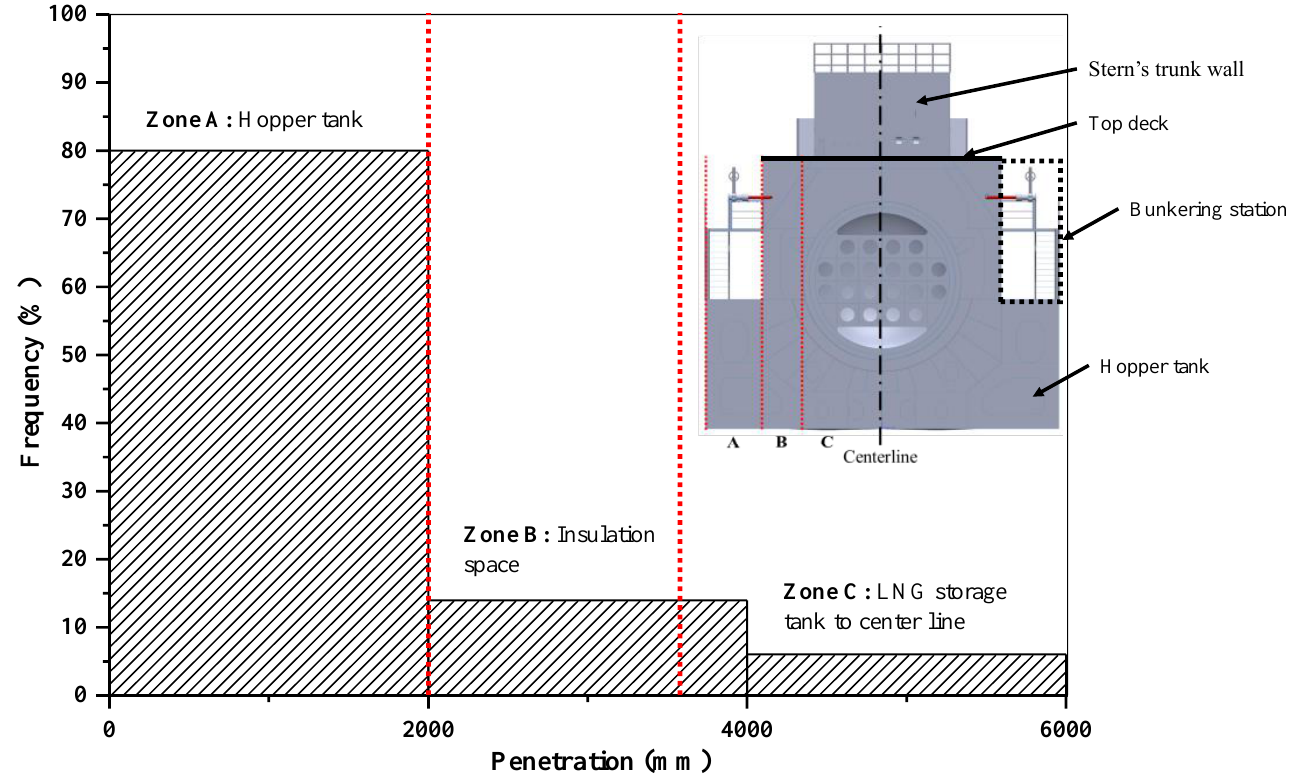
Figure 2. Frequency of penetration distance. The penetration region was categorized into zones A, B, and C, which represent slight, middle, and severe penetrations, respectively. Zone B, which has 3500 mm depth penetration, was selected to represent the damaged condition. The degraded region was located at frames 25 to 38 which have a width of 7500 mm, since the target ship was struck around the midship on the portside. With these assumptions and considerations, the damaged ship can be modeled. Figure 3 shows both models of the LNG bunkering ship. The LNG bunkering ship was built with two bunkering stations located on each side of the ship so that it can simultaneously serve two ships. Figure 3b shows that the bunkering station does not exist on the port side of the damaged model. In addition, there is an opening in the cargo casing that exposes the LNG storage tank. The engine room is, however, secure since there is a bulkhead that separates the cargo hold and engine room, as shown in Figure 3c. The current LNG bunkering ship stores the LNG cargo inside a Type-C independent tank. Two tank saddles are installed below the storage tank to secure it inside the cargo casing. The Type-C tank was built with three swash bulkheads to decrease the sloshing effect. In addition, two ring stiffeners were installed to ensure adequate strength of the storage tank. The tank dome emerges onto the top deck or fuel supply deck where several valves were